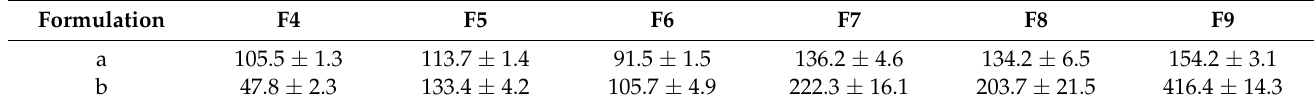
Table 3. The obtained values of parameters a and b from the Equation (9).